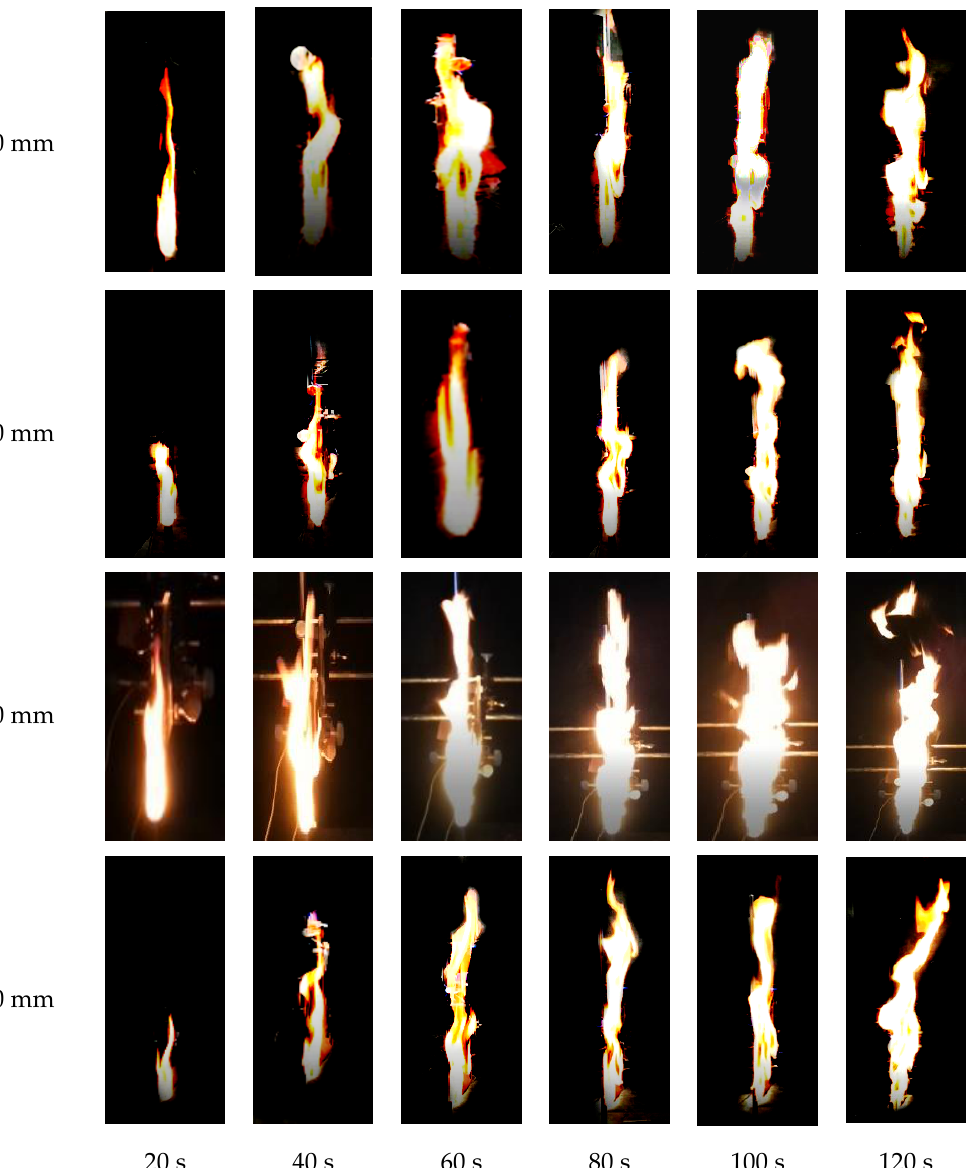
ff erent time and overlap